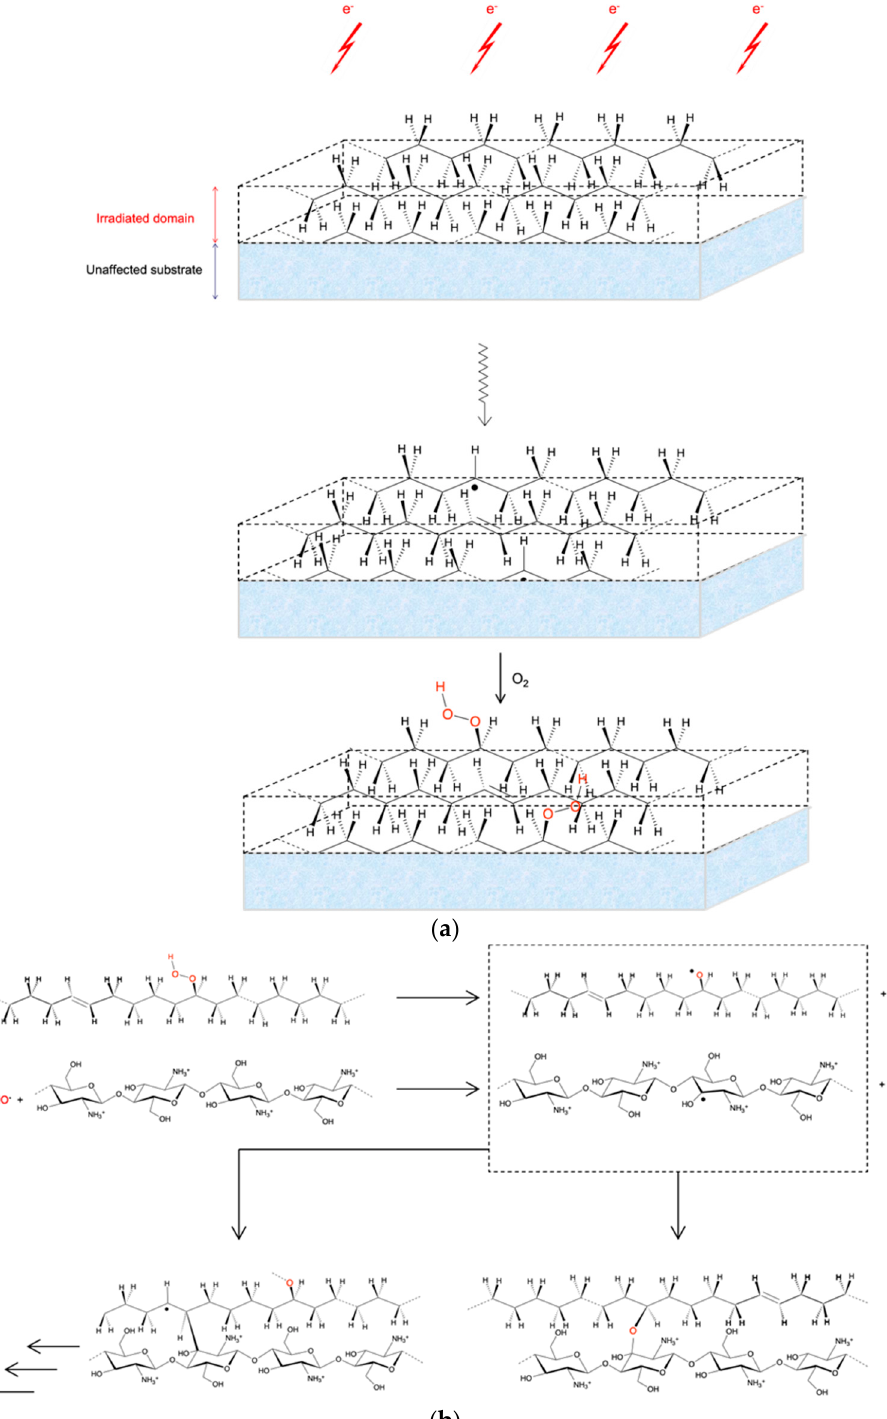
Scheme 1. Simplified representation of the 2-stage modification of HDPE-based materials to immobilise chitosan on the surface: formation of hydroperoxide by pre-irradiation of HDPE in air ( a ) and decomposition of peroxides on a PE chain and grafting of chitosan after attack by HO• radicals and reaction with the HDPE substrate ( b ). reaction with the HDPE substrate ( b